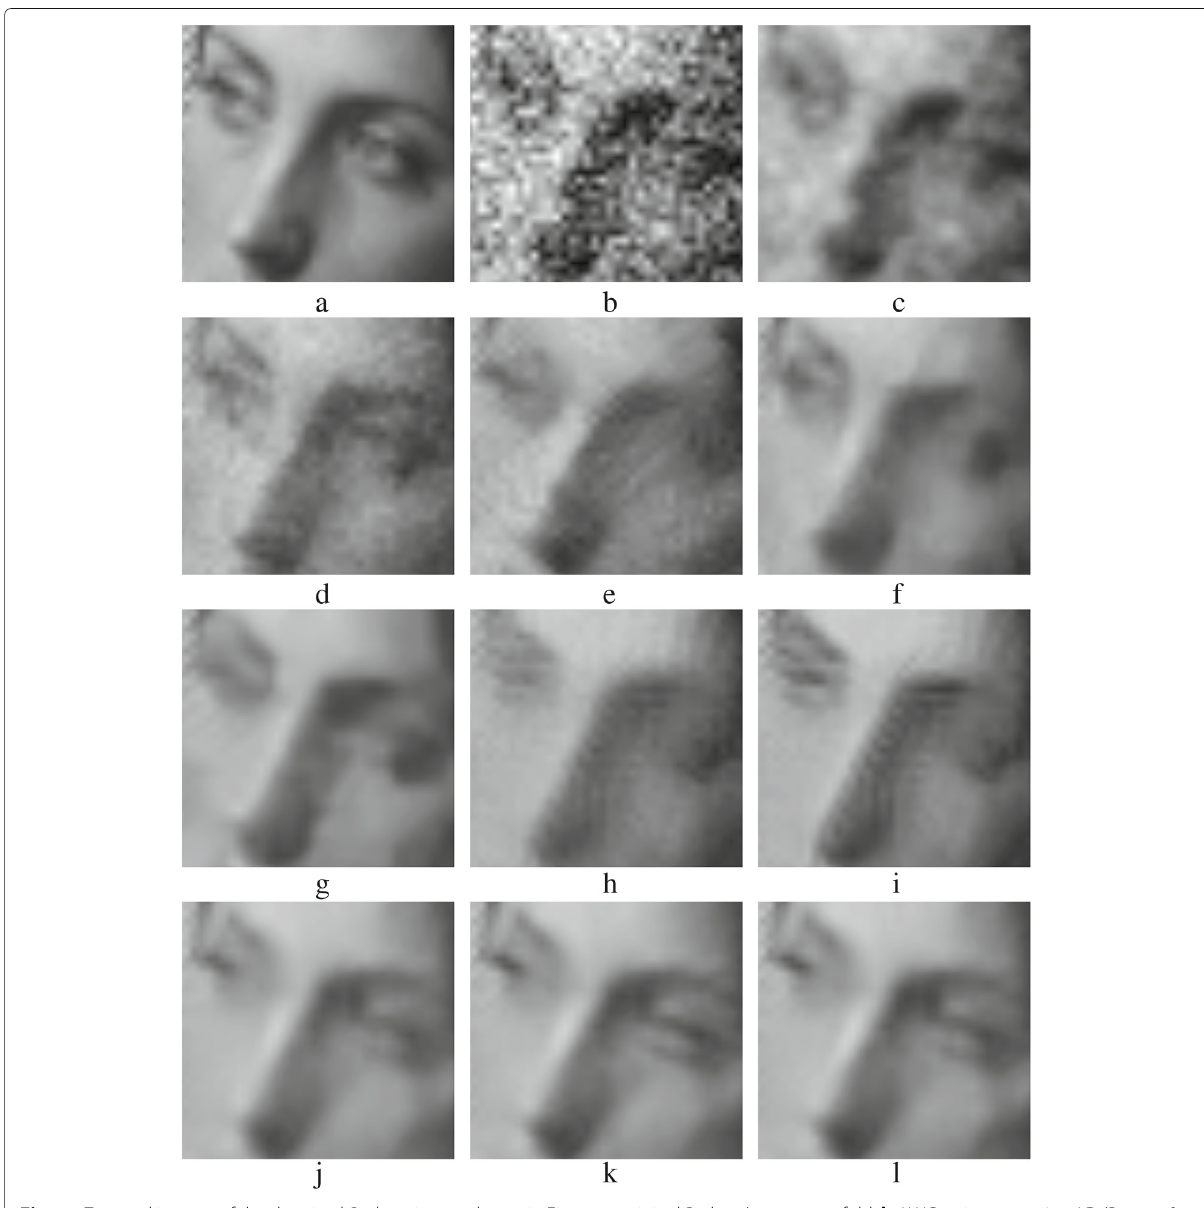
Fig. 17 Zoomed images of the denoised Barbara image shown in Fig. 15: a original Barbara’s eye cover fold; b AWG noise, σ = 40; c AD (Perona & Malik); d bilateral filtering; e NL-Means filtering; f K-SVD; g BM3D; h Non-itPPB; i It-PPB; j PGPCA; k PLPCA; and l